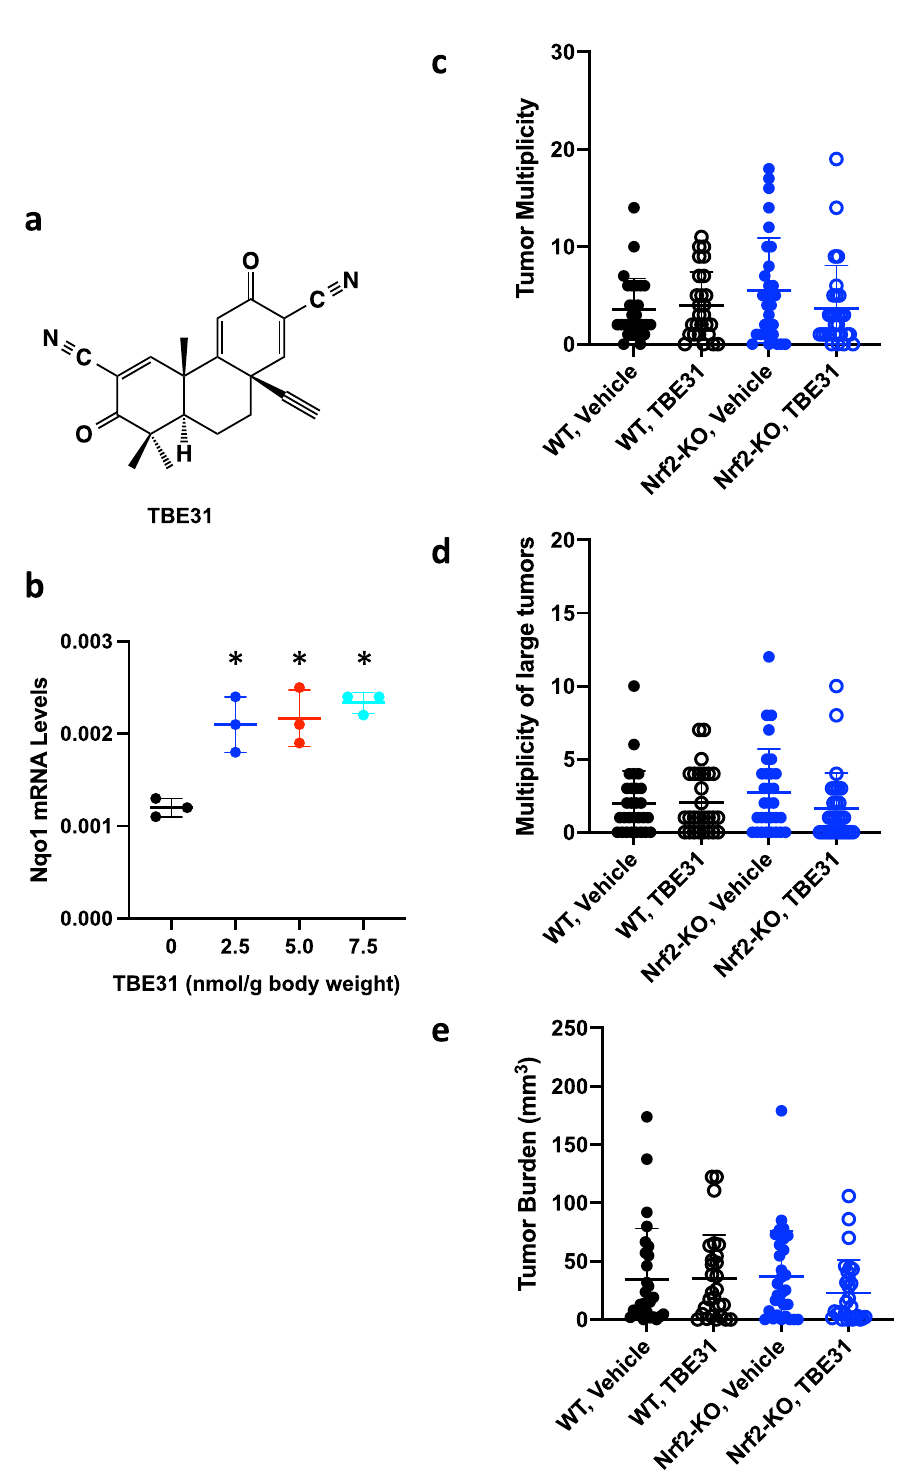
Fig. 9 Chronic pharmacological activation of Nrf2 by TBE-31 does not affect colorectal adenoma formation in Gstp − / − : Apc Min/ + mice. a Chemical structure of TBE-31. b mRNA levels for Nqo1 in colons from Gstp − / − : Apc Min/ + : Nrf2 + / + : Keap1 + / + (WT) mice ( n = 3 – 4) that had been treated with vehicle (0.7% DMSO in corn oil) or the indicated doses of TBE-31, per os , 3 days per week for 1 week, 72h-, 48h- and 48h-apart; colon tissue was harvested 24 h after the last dose. Actb was used as the reference gene. * p < 0.05 vs. vehicle-treated. c – e Tumor multiplicity ( c , d ) and burden ( e ) in colons of 20- week-old Gstp − / − : Apc Min/ + : Nrf2 + / + : Keap1 + / + (WT, black circles) and Gstp − / − : Apc Min/ + : Nrf2 − / − : Keap1 + / + ( Nrf2-KO, blue circles) mice ( n = 27 – 30) that had been treated per os with vehicle (0.7% v/v DMSO in corn oil, closed circles) or TBE-31 (5 nmol/g body weight, 3 days per week for 12 weeks, starting at week 8 of age, open